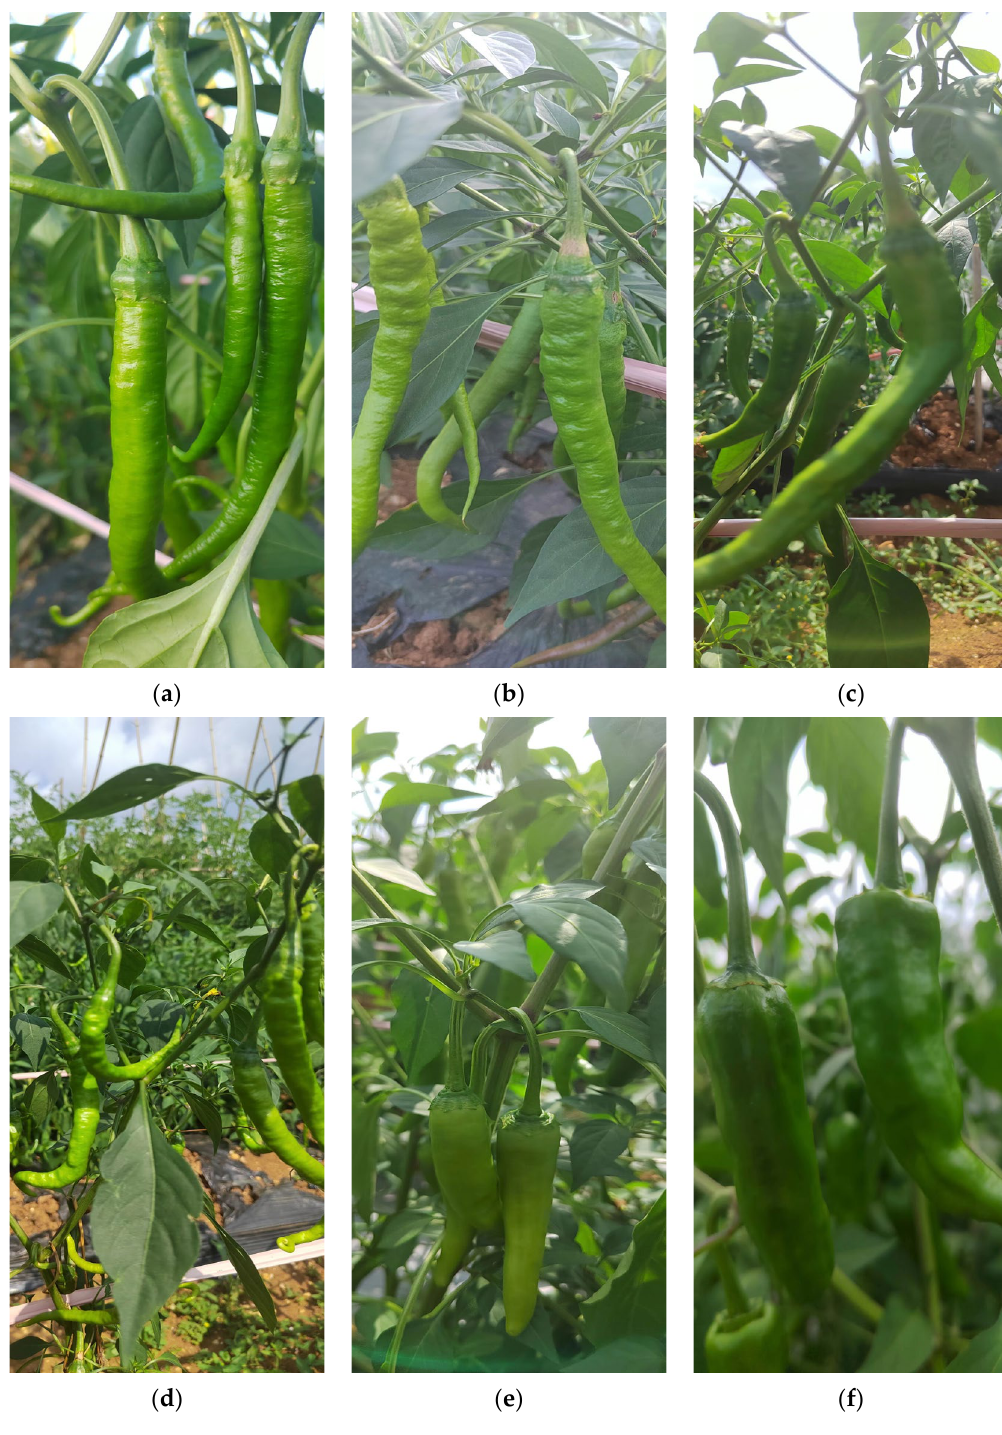
Figure 8. Pictures of chilies in different environments. ( a , b ) are pictures of chili under different degrees of occlusion. ( c , d ) are chili images under positive light. ( e ) chili image under backlight conditions. ( f ) chili image under cloudy